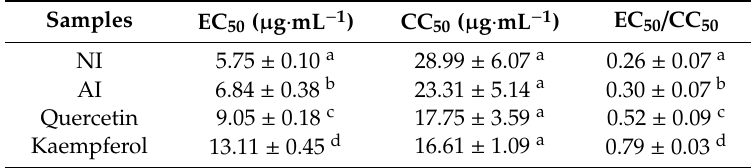
Table 1. EC 50 , CC 50 , and EC 50 / CC 50 values of the non-hydrolyzed isolate (NI) and acidolyzed isolate (AI) of Ginkgo biloba leaf, quercetin, and kaempferol upon treatment of the di ff erentiated PC-12 cells.